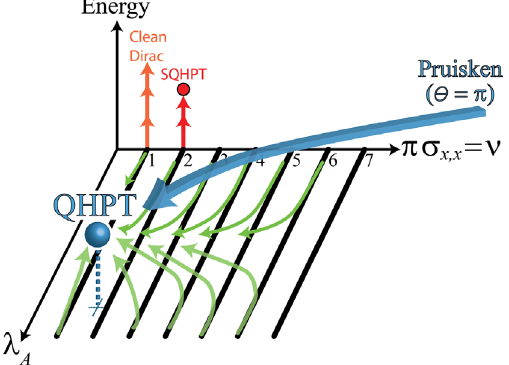
FIG. 12. Schematic “ physical ” renormalization group flow picture connecting zero-energy and finite-energy fixed-point descriptions of class AIII topological surface states. In the zero-energy horizontal plane, the system state is determined by the winding number ν [equal to π times the longitudinal conductivity, Eq. (14)] and by the Abelian disorder strength λ , A Eqs. (10) and (32). The latter parametrizes the parallel zero- energy fixed lines, indicated in black. The numerical results presented in Secs. III, IV, and VI strongly suggest that nonzero energy induces a flow (green arrows) to the logarithmic con- formal field theory that governs the plateau transition of the 0 , finite energy produces ordinary quantum Hall effect. For λ A ¼ special behavior for winding numbers ν ¼ 1 (clean Dirac) and ν ¼ 2 . The latter flows instead to the plateau transition of the spin quantum Hall plateau transition (SQHPT) [20]. Also indicated is the schematic flow to the QHPT critical point from the ultraviolet limit of the quantum Hall plateau transition, as captured by the Pruisken σ model in Eq. (35) with a large bare conductivity σ ≫ 1 and half-integer σ x;x x;y